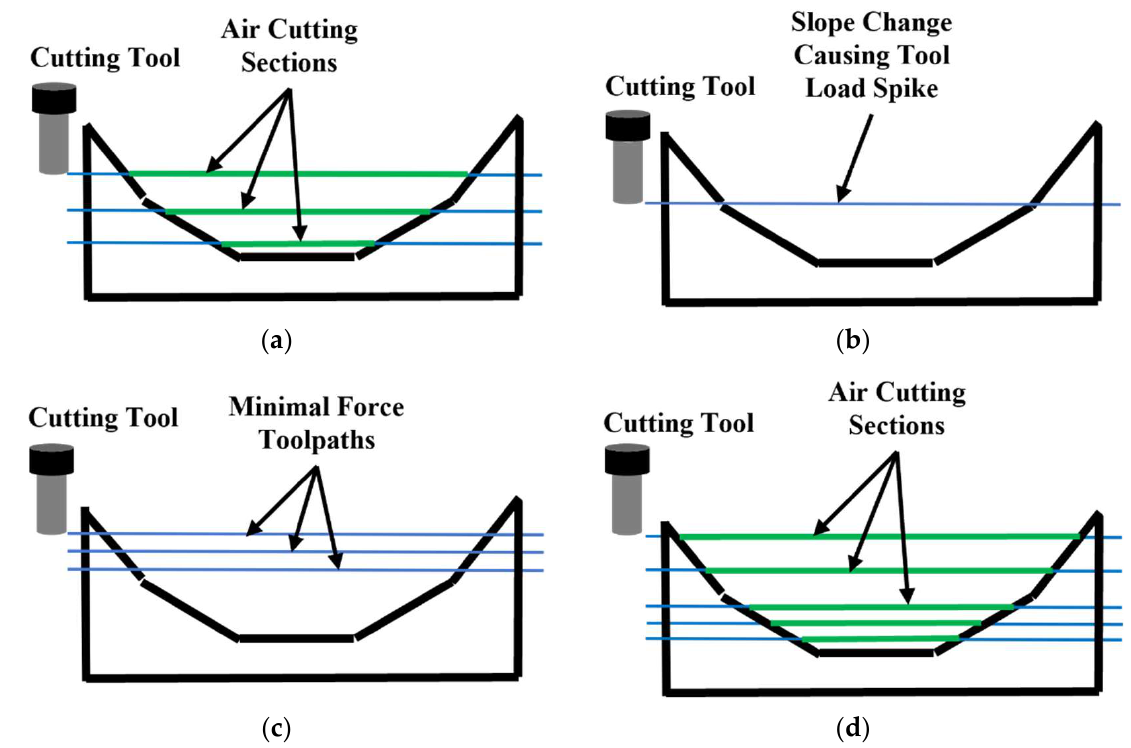
Figure 1. Approximation of the cup-shaped geometry (black outline) with corresponding toolpath issues: ( a ) non-optimized toolpath showing air cutting toolpath sections (green) and engagement toolpath sections (blue); ( b ) non-optimized toolpath showing a spike in tool load; ( c ) partially optimized toolpath that makes tool load more uniform; ( d ) fully optimized toolpath that minimizes machining time, cutting force, and surface roughness.